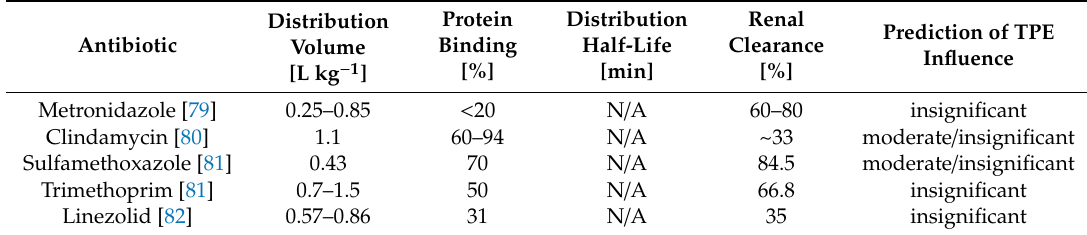
Table 7. TPE and other popular antimicrobial